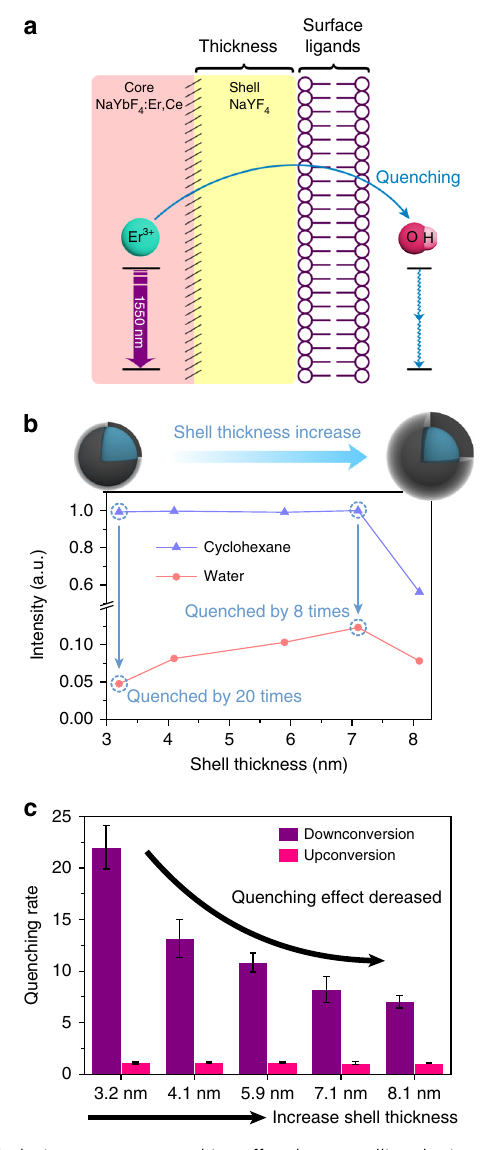
Fig. 3 Reducing aqueous quenching effect by controlling the inert shell thickness of Er-RENPs. a Schematic illustration of the proposed quenching mechanisms of Er-RENPs in aqueous solution. b Schematic representation of shell thickness and corresponding 1550 nm downconversion emission intensity of the Er-RENPs in organic and aqueous phase upon 980 nm excitation. c Quenching rate of upconversion and downconversion emission as a function of shell thickness (from 3.2 nm to 8.1 nm). Three surface coating experiments were performed for each Er-RENPs sample. All data are presented as means ±